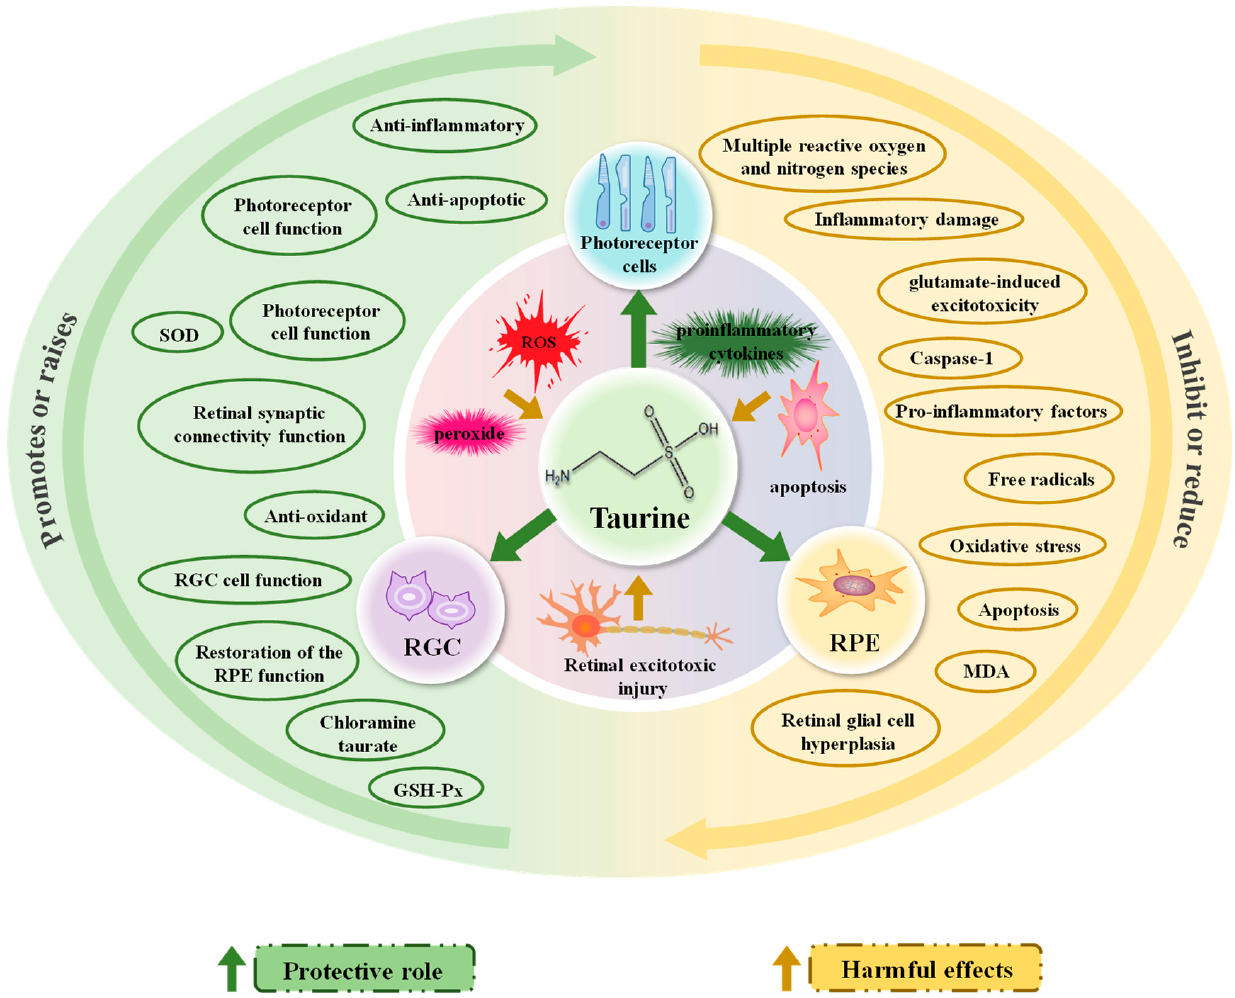
Figure 3. The main mechanisms by which taurine protects the retina to reduce visual fatigue. Tau- rine protects photoreceptor cells, RGC and EPE cells from damage caused by oxidative stress, in- flammation, apoptosis and ocular neurotoxicity through various pathways (reducing adverse ef- fects or promoting beneficial effects), thereby reducing visual fatigue.